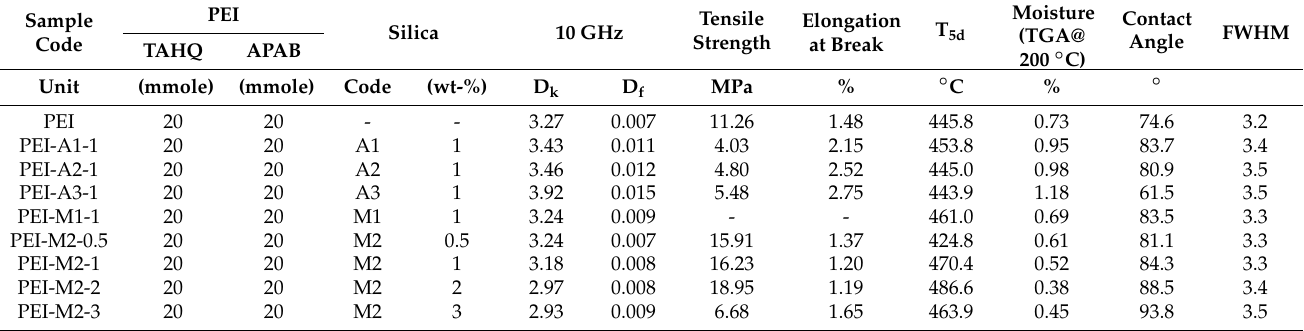
Table 2. Formulation and analytical data of the dielectric properties, mechanical strengths,